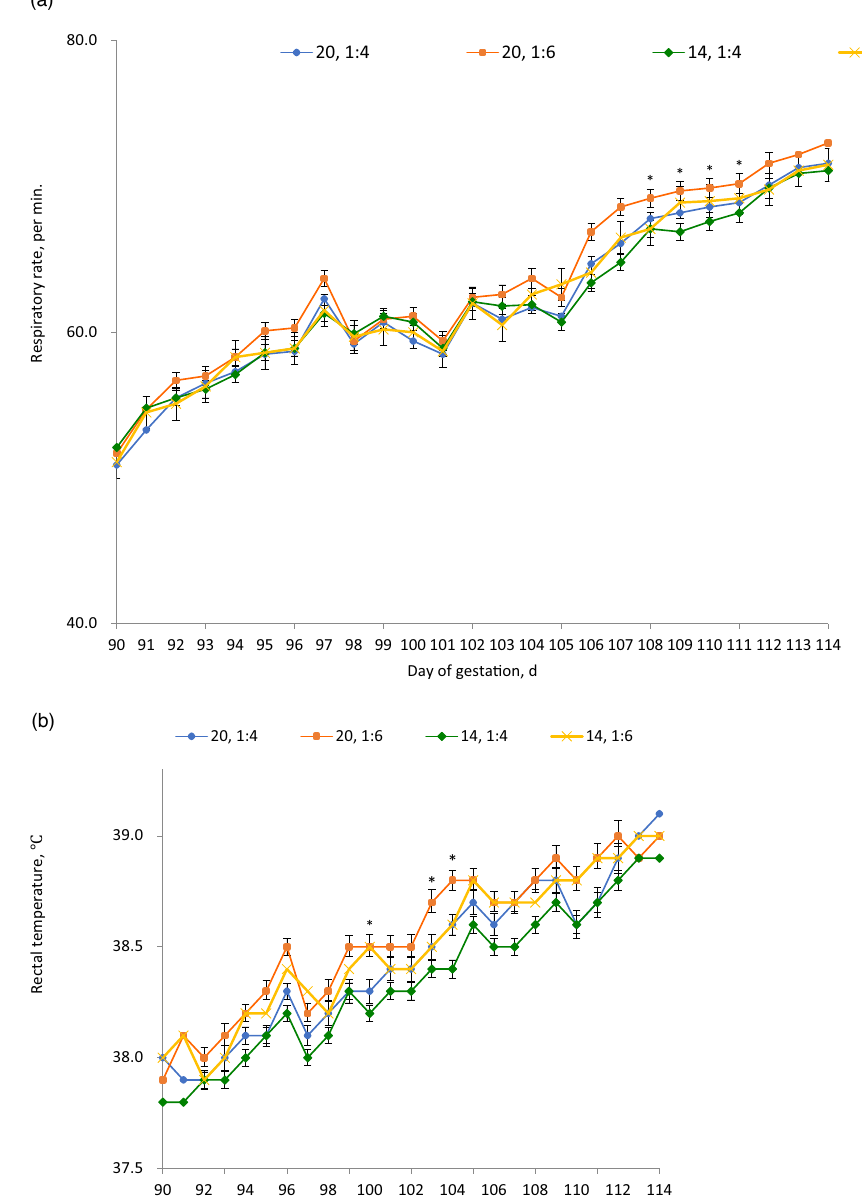
Figure 1. Effect of dietary fiber levels and soluble, insoluble dietary fiber ratio on: ( a ) respiration rate, ( b ) rectal temperature of sows during heat stress. Asterisks(*) indicate statistical significance (P <